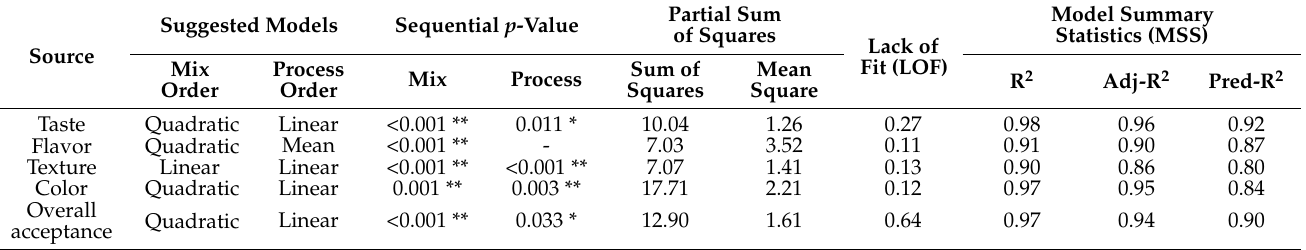
Table 2. Combined model mixture process fit summary and analysis of variance (partial sum of